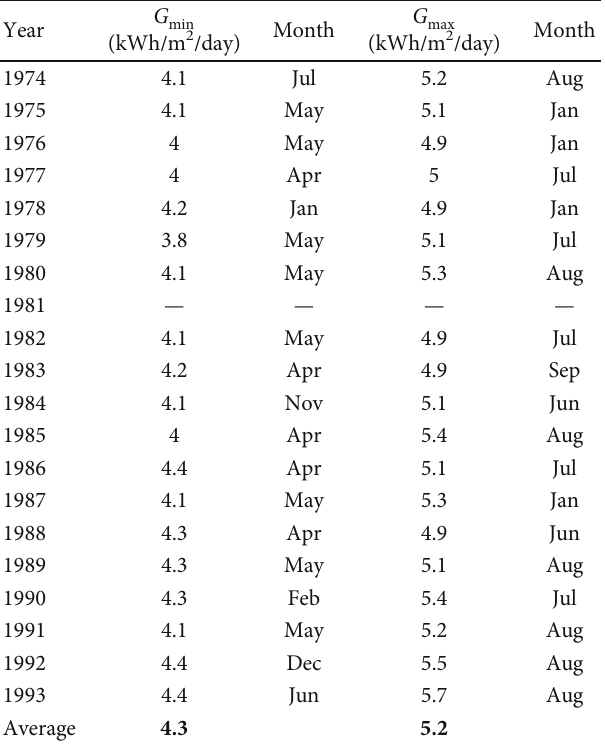
Table 8: The minima and maxima values of monthly averaged global solar radiation over the period of 1974 – 1993